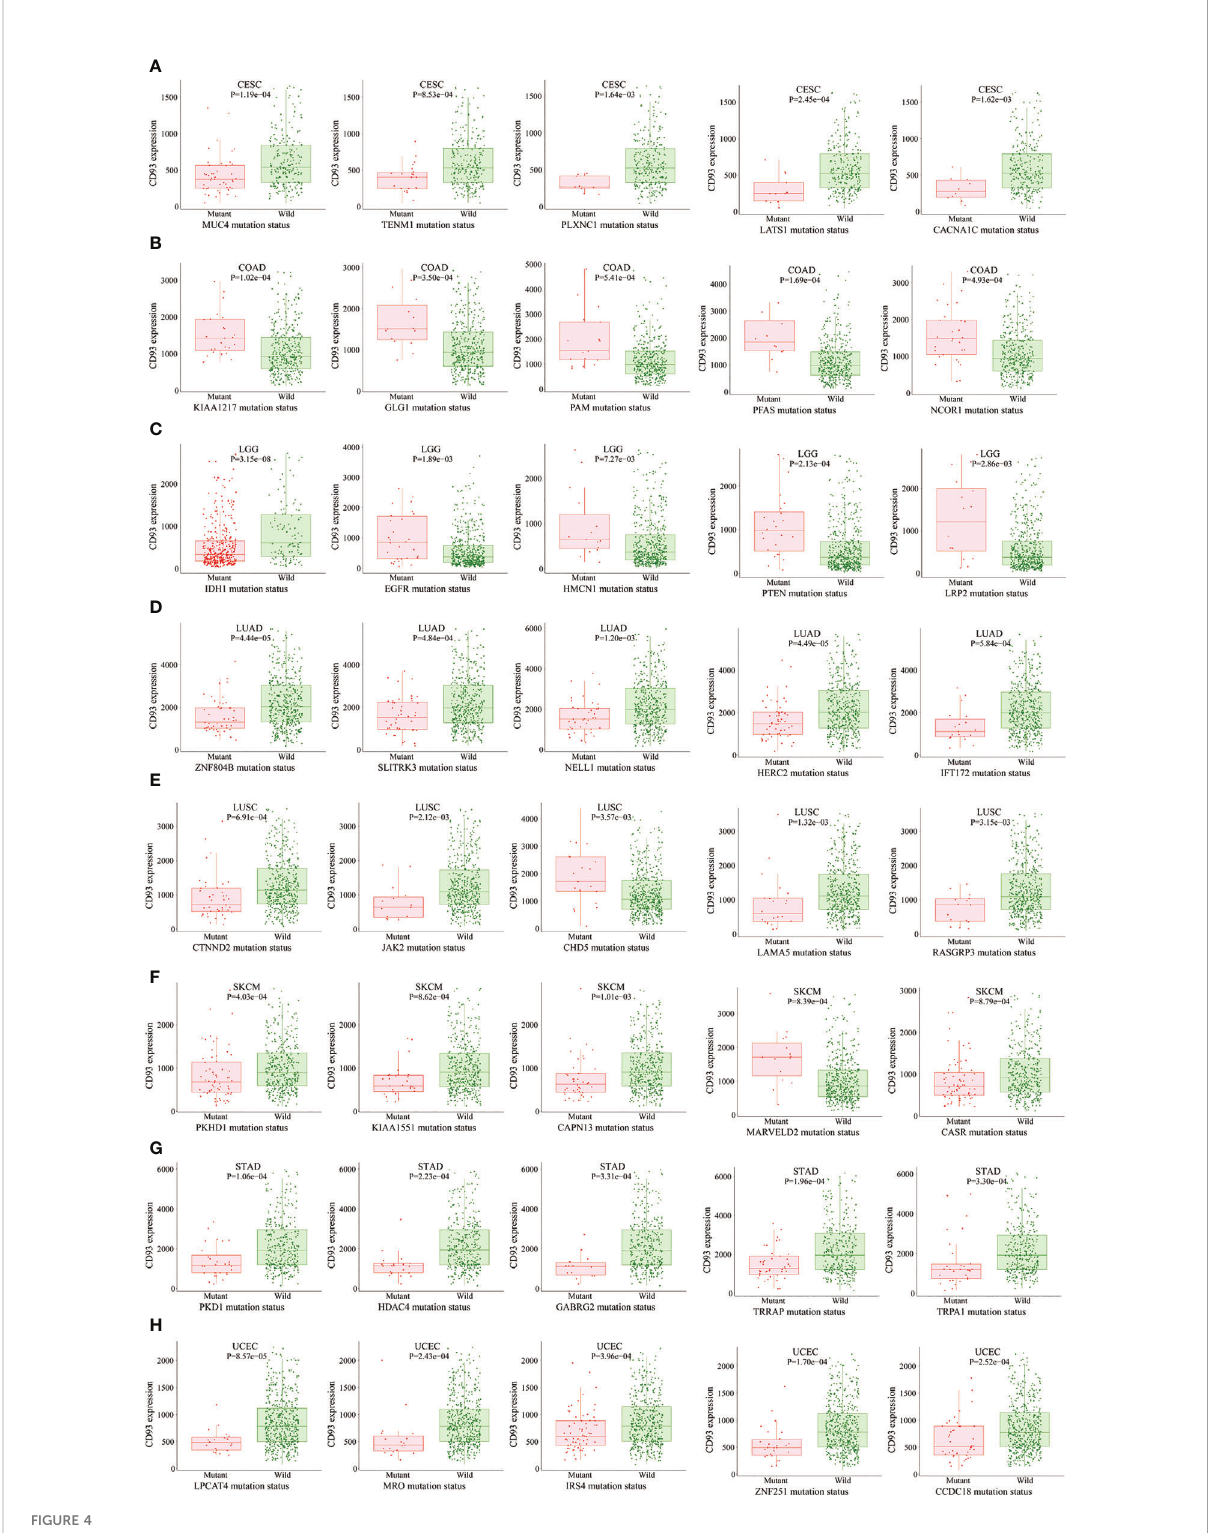
FIGURE 4 The correlation between CD93 expression and gene mutation status. CESC (A) , COAD (B) , LGG (C) , LUAD (D) , LUSC (E) , SKCM (F) , STAD (G) , and UCEC (H)